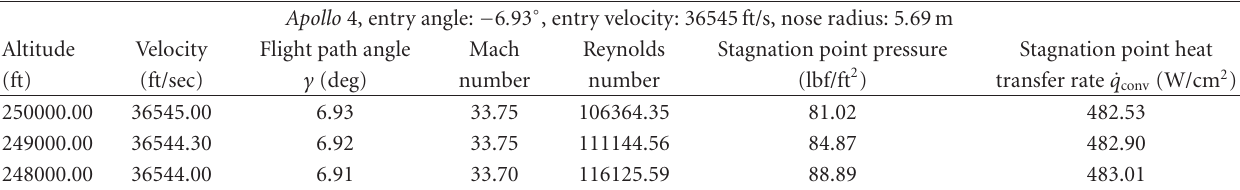
Table 2: OLAP driven trajectory analysis for Apollo 4 at an entry velocity of 36545 ft/s and R n = 5 .